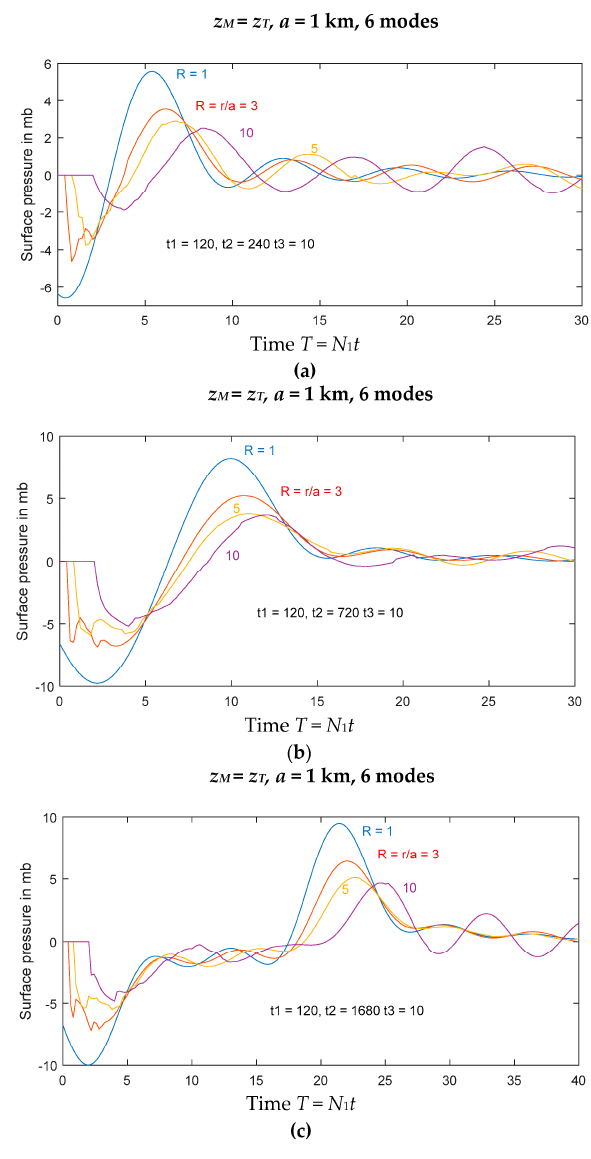
Figure 5. As for Figure 4, but with increasing duration of eruptions at a constant rate after a 2-min. buildup. The total time of the eruption is: ( a ) 4 min; ( b ) 12 min; and ( c ) 28 min. The initial decrease in pressure is present in all cases, but the subsequent maximum is increasingly delayed, and could be regarded as a long period wave, from observations.